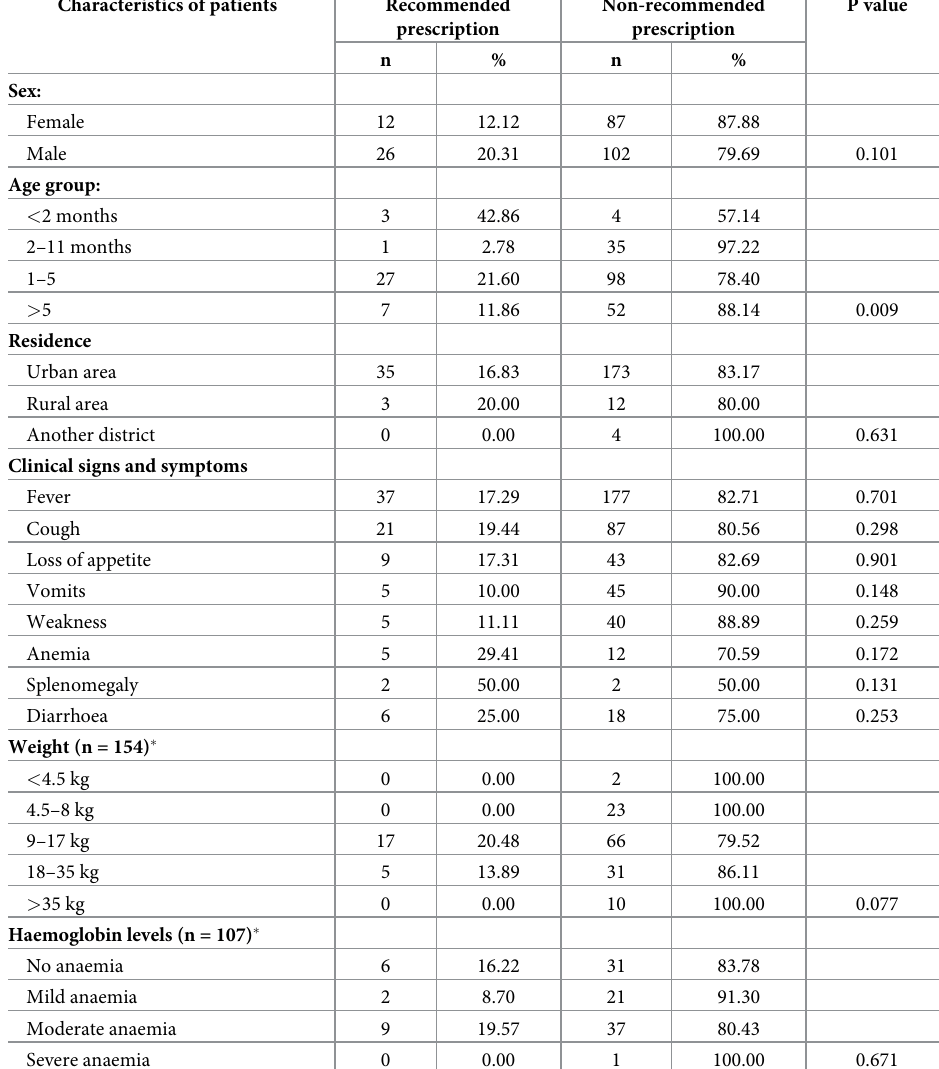
Table 2. Characteristics of patients and symptons by prescription. Characteristics of